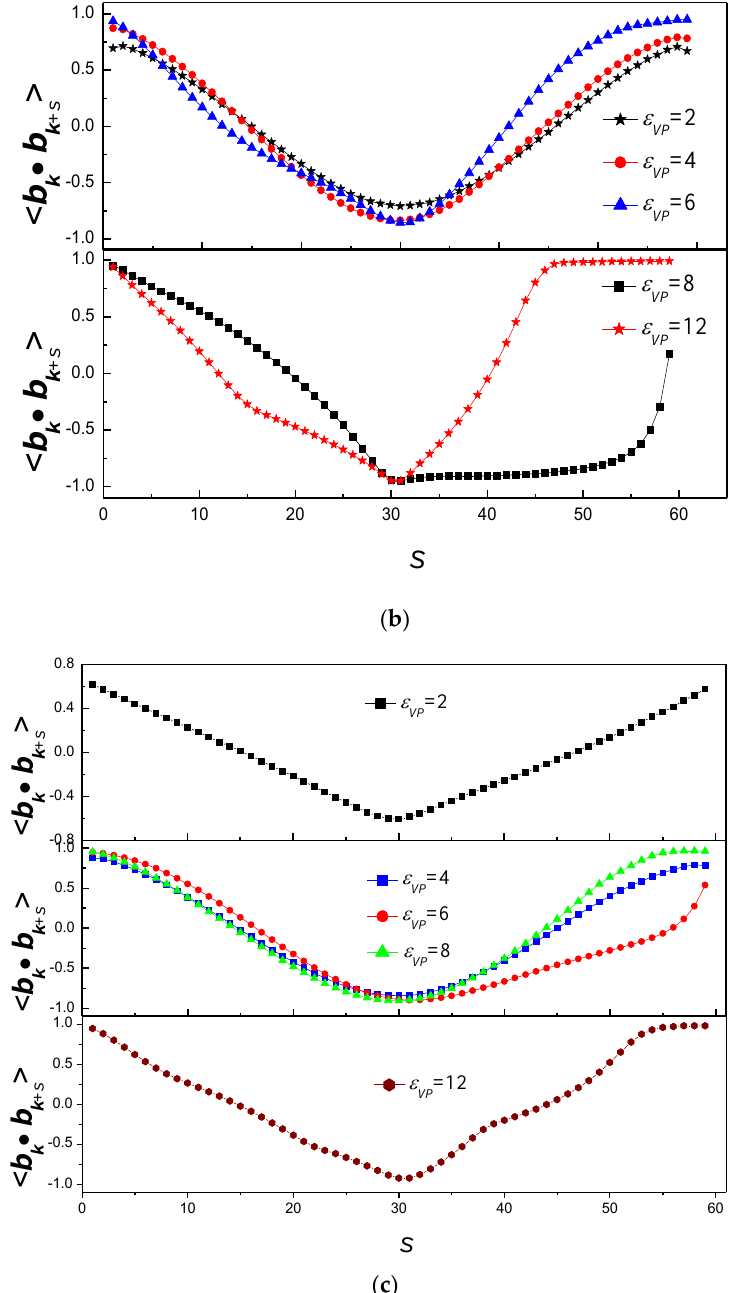
Figure 8. Tangent – tangent correlation of vesicle whose transformation is induced by linear poly- Figure 8. Tangent–tangent correlation of vesicle whose transformation is induced by linear polymer mer of ( a )  = 10, ( b )  = 150, and ( c )  = 300. of ( a ) κ = 10, ( b ) κ = 150, and ( c ) κ =